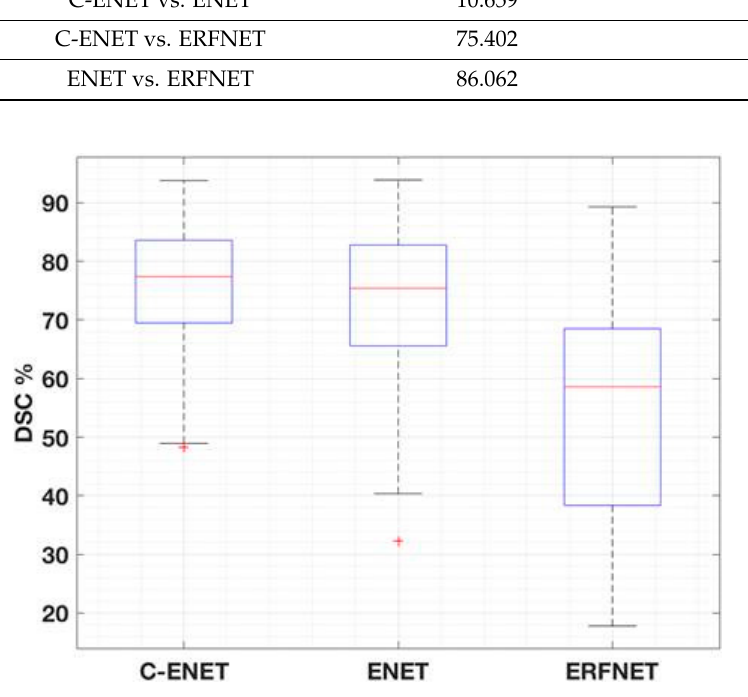
Table 4. Tukey HSD was used as a multiple comparison correction technique.